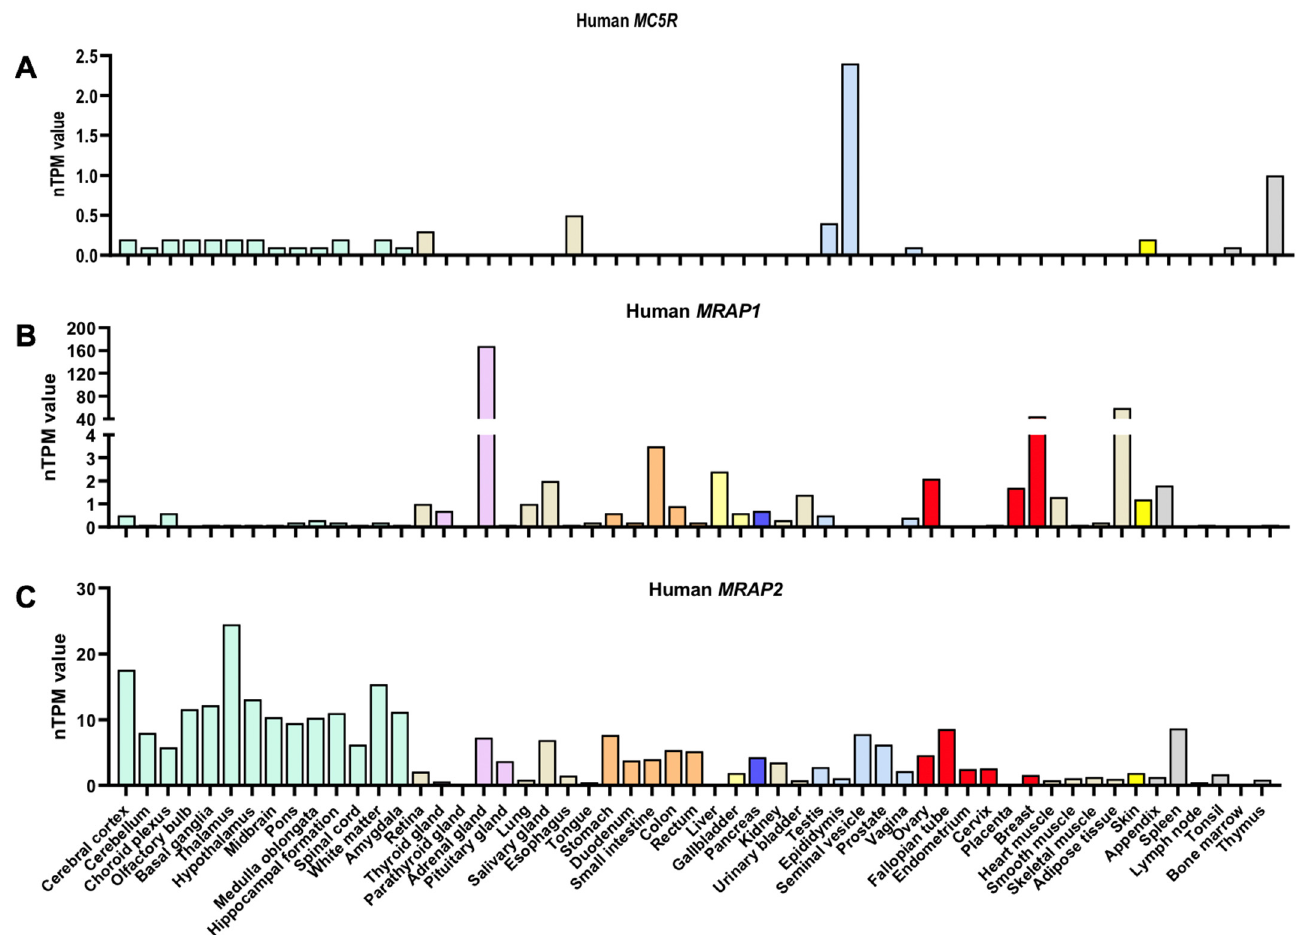
Figure 5. Human MC5R ( A ), MRAP1 ( B ), and MRAP2 ( C ) mRNA expression in various tissues, based on https://www.proteinatlas.org/ (accessed on 14 July 2022) [85]. nTPM indicates normalized protein-coding transcripts per million. Color coding is based on tissue groups with functional features in common .